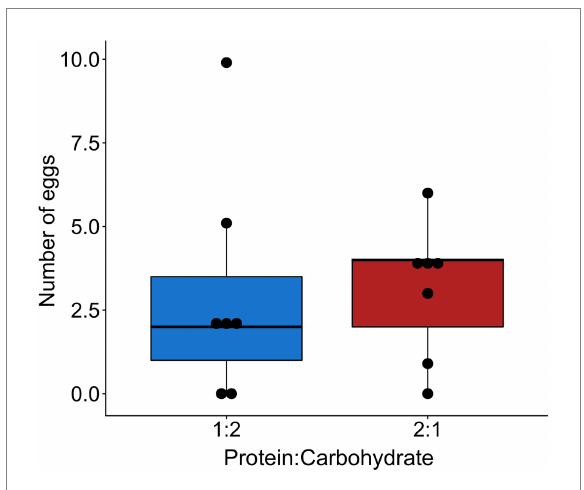
FIGURE 2 Cumulative number of worker-laid eggs after 8 weeks depending on the protein to carbohydrate ratio in the diet ( p =